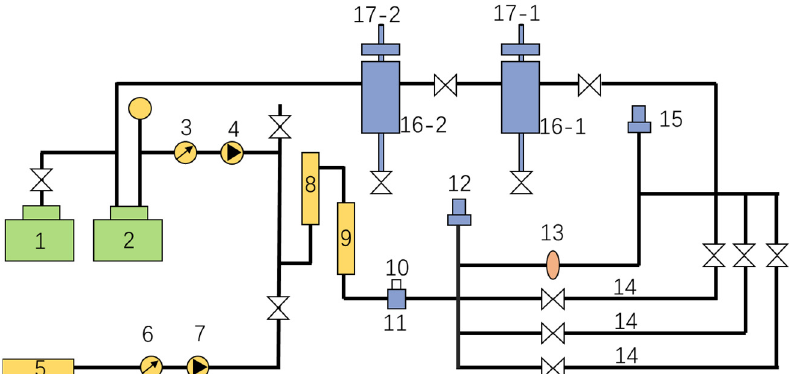
Figure 3. Test device for measuring frictional drag in high-temperature and high-pressure fluid cir-